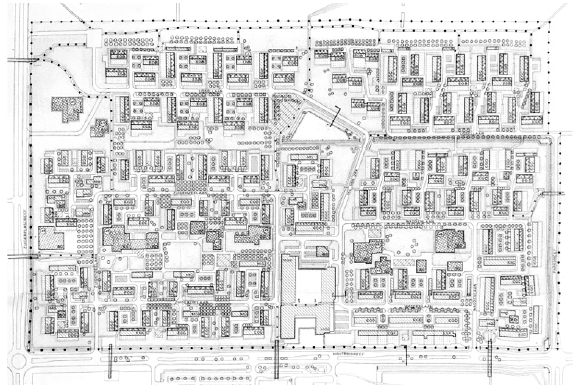
Figure 8. Zuiderzeewijk’s urban layout. Source: Flevolands